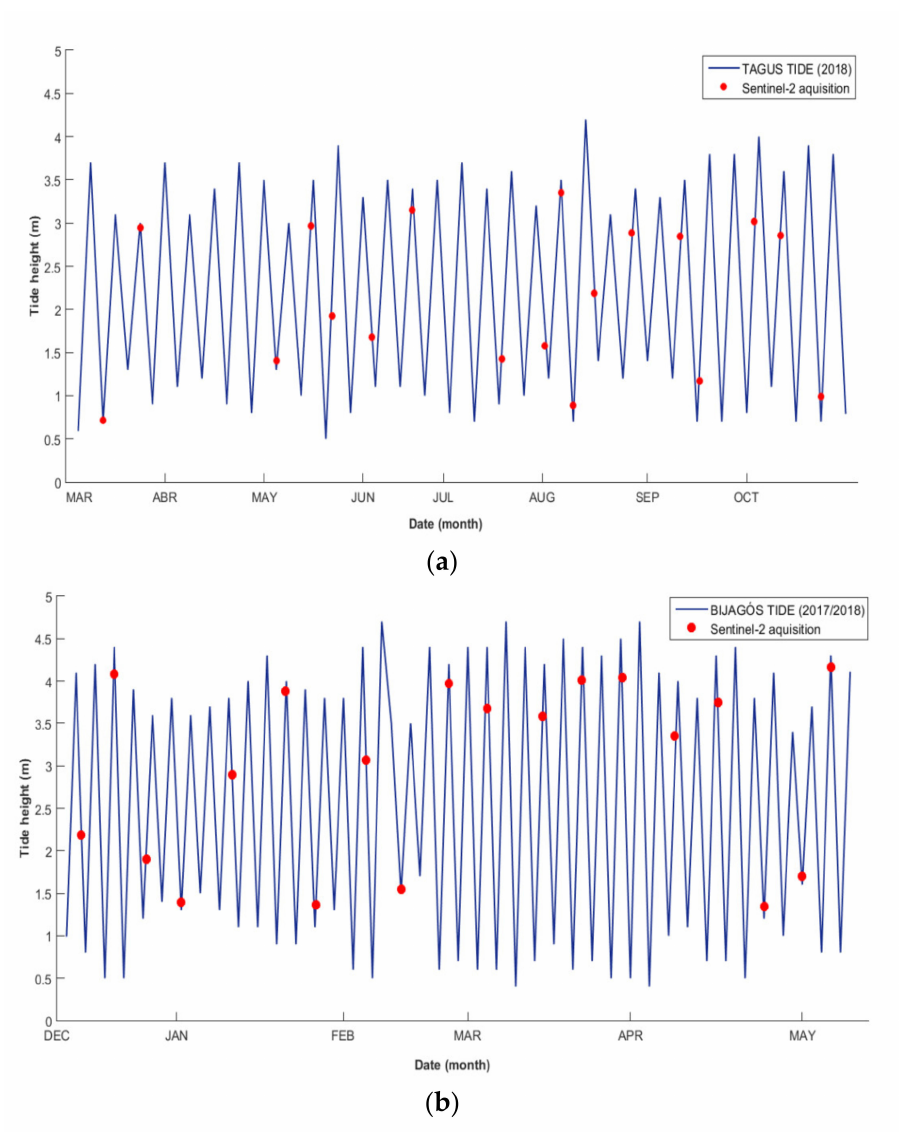
Figure 3. Tidal height variation: ( a ) Tide height at Tagus estuary from March to October 2018 and ( b ) Tide height at Bijag ó s archipelago from December 2017 to May 2018. The red dots represent the Sentinel-2 images dataset (time—11:21